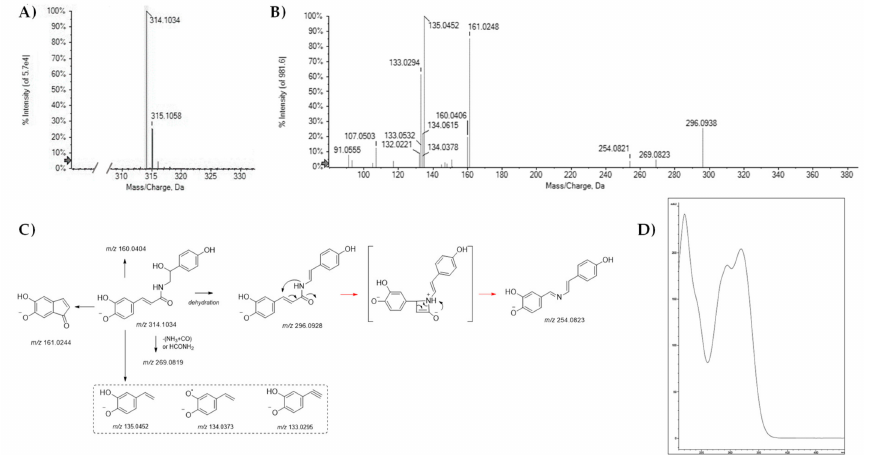
Figure 1. ( A ) and ( B ) TOF-MS and TOF-MS / MS spectra for compound 1 ; ( C ) proposed fragmentation pathway of the [M − H] − ion; ( D ) UV-DAD spectrum. In C panel, the theoretical m / z value is reported below each